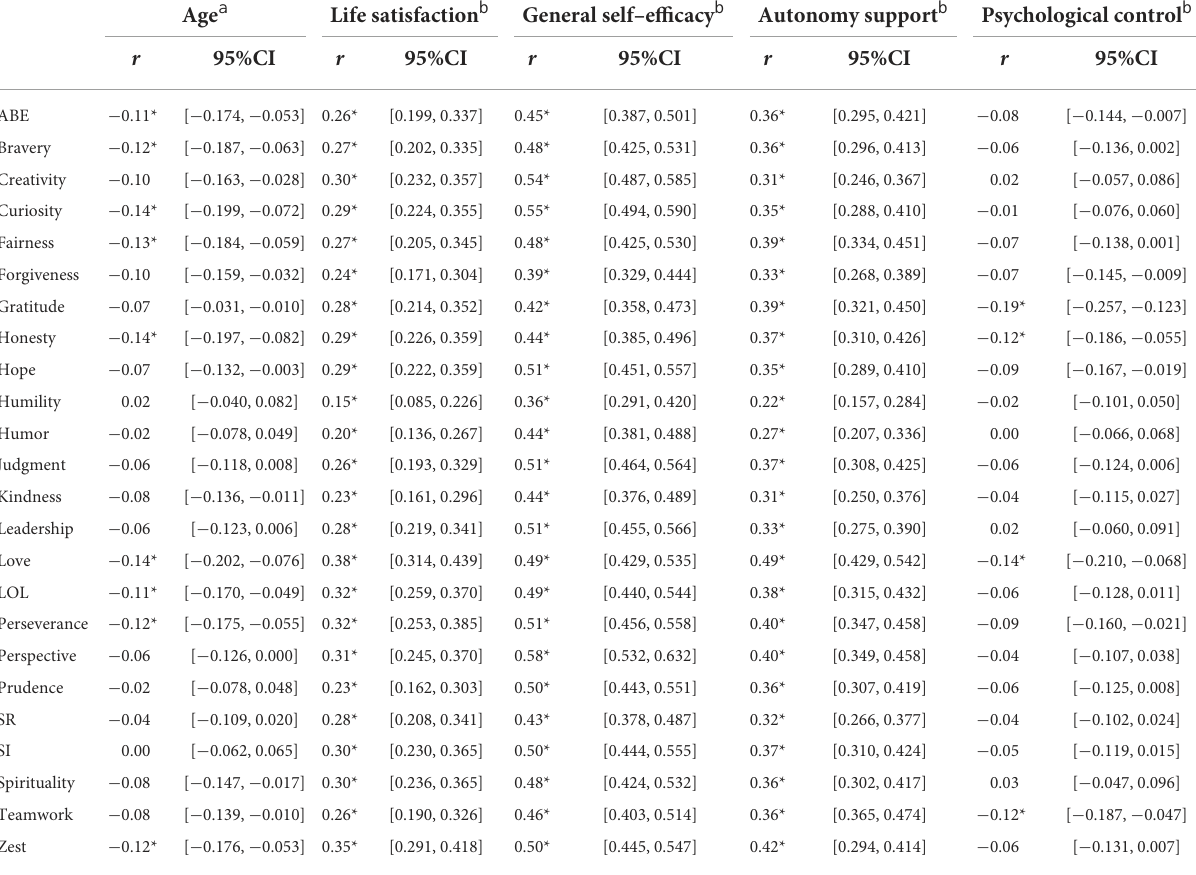
TABLE 2 Correlation